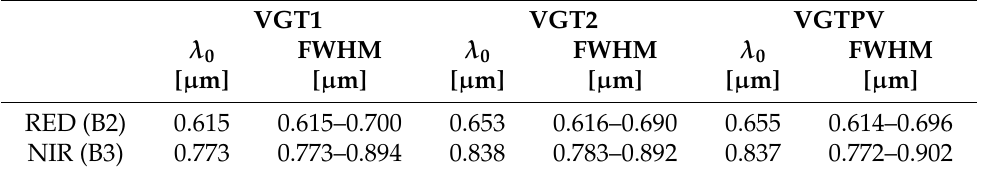
Table 1. RED and NIR Spectral ranges of the VEGETATION instruments. λ 0 and FWHM are the center wavelength and full width at half maximum, respectively. Information taken